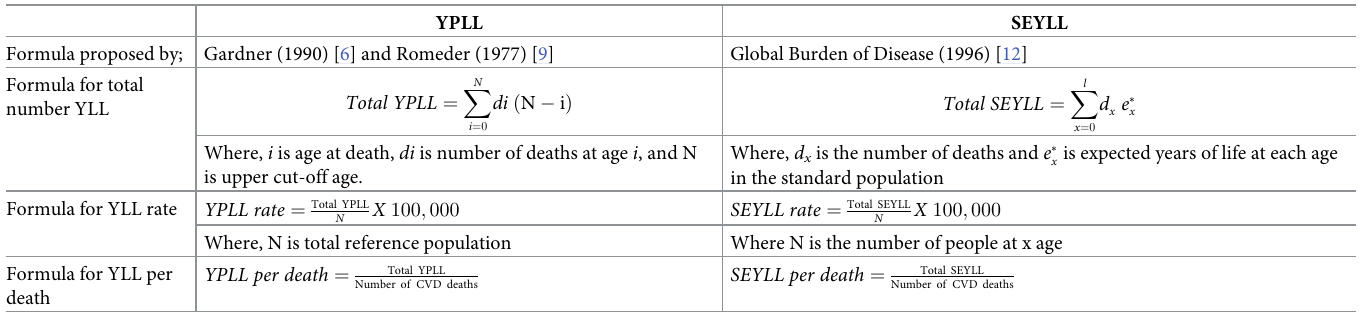
Table 1. Formulas for years of potential life lost (YPLL) and standard expected years of life lost